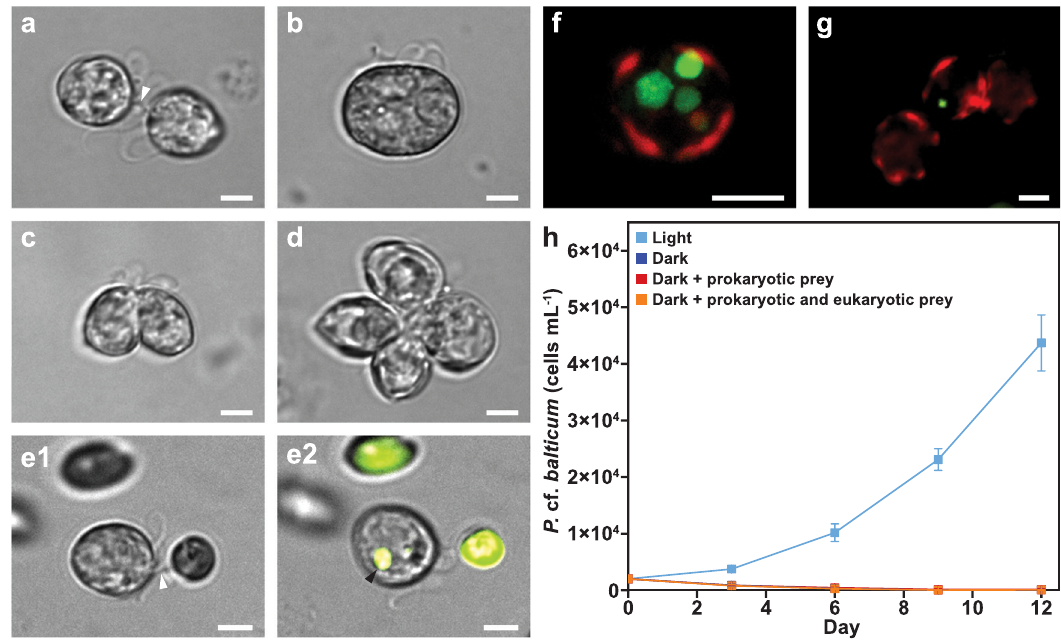
Fig. 2 Evidence of sexual reproduction stages and peduncular phago-heterotrophy discovered for Prorocentrum cf. balticum . Images a - d show the various stages of sexual reproduction (Supplementary Note 2); extraction of the nucleus through the peduncle (white arrow) ( a ), replication of DNA ( b ), fi rst meiotic division ( c ), and second meiotic division resulting in a tetrad ( d ). e1, e2 Peduncular feeding mechanism (white arrow) used for phago- heterotrophic consumption of a R. salina prey cell and the resulting green- fl uorescent food vacuole (black arrow). f , g Fluorescent microscope images showing: the peripheral red- fl uorescent chloroplasts and intracellular green- fl uorescent food vacuoles following consumption of the cryptophyte R. salina ( f ), and an ingested green- fl uorescently labelled bacterium ( g ). h Growth of P . cf. balticum in co-culture ± prokaryotic (natural microbiome from xenic culture) and/or eukaryotic prey ( Proteomonas sulcata ) in light and dark conditions. Mean ± standard deviation ( n = 6). Note that the three treatments in the dark did not grow and are overlapping with low P . cf. balticum densities. Images a – e , g were taken with an Inverted Fluorescence Microscope (Nikon Eclipse Ti), fi tted with Nikon FITC 480/30 nm ex 535/45 nm em and Texas Red 560/40 nm ex 630/60 nm em fi lters, and a monochrome camera (Nikon DS- QiMc 12 bit) under 200 or 400× magni fi cation. Image f was taken with a Nikon AR1 confocal microscope using lasers with 405.6 – 561.0 nm ex and TRITC 595 nm em, Alex610 700 nm em and TD fi lters at 1000× magni fi cation with oil immersion and represents a collapsed Z-stack of 26 images (6.5 µ m total distance) to clearly show the food vacuoles. Scale bars = 5 µ